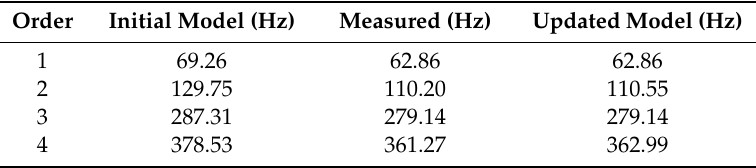
Figure 4. Flowchart of the proposed method.